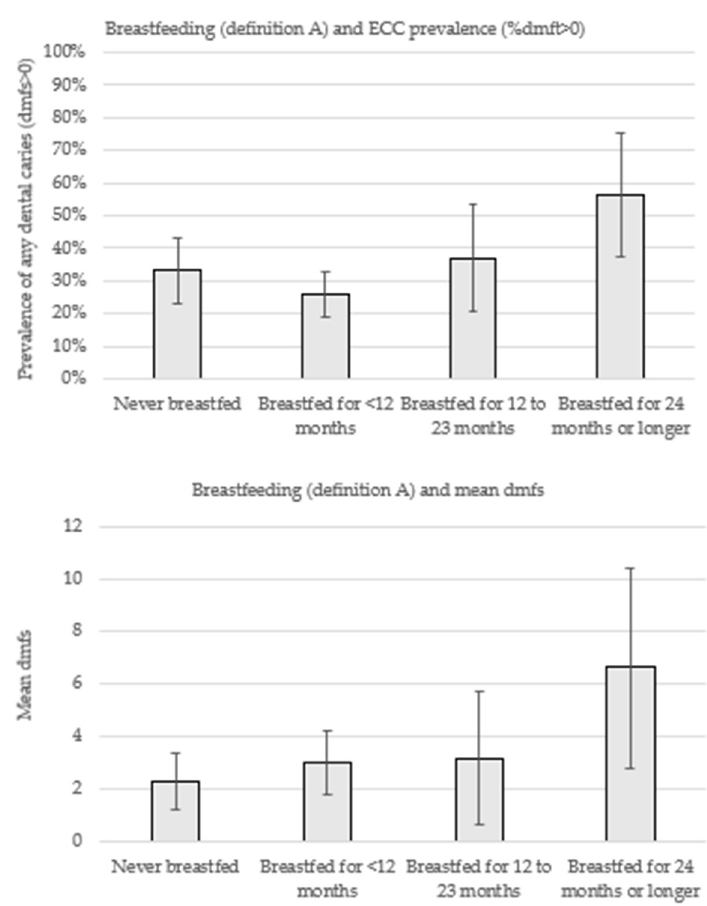
Figure 1. Prevalence of early childhood caries (ECC) and mean number of decayed, missing, and filled teeth (mean dmfs) according to breastfeeding patterns (definition teeth (mean dmfs) according to breastfeeding patterns (definition A).